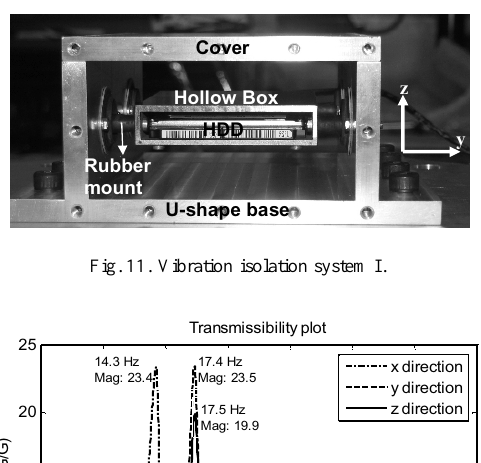
Fig. 10. Vibration isolator mount with additional stiff isolator ( k 2 ).